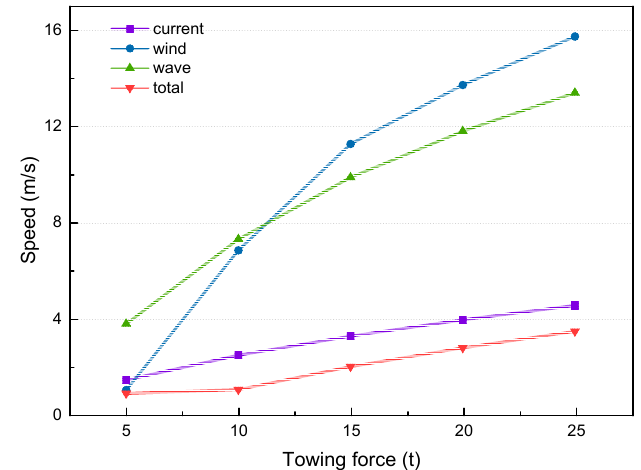
Figure 4. Comparison between the towing speed under different sea loads varying with the towing force by MOSES. force by